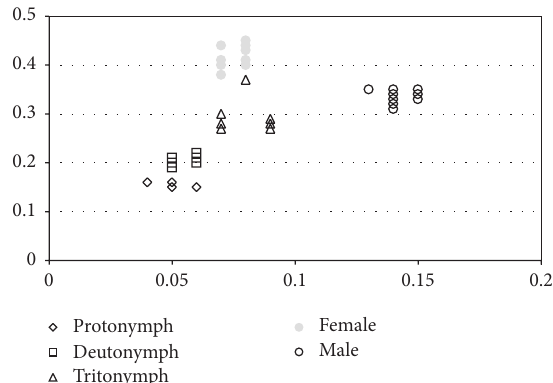
Figure 2: Tarsus IL/W of all postlarval stages of Dactylochelifer gracilis